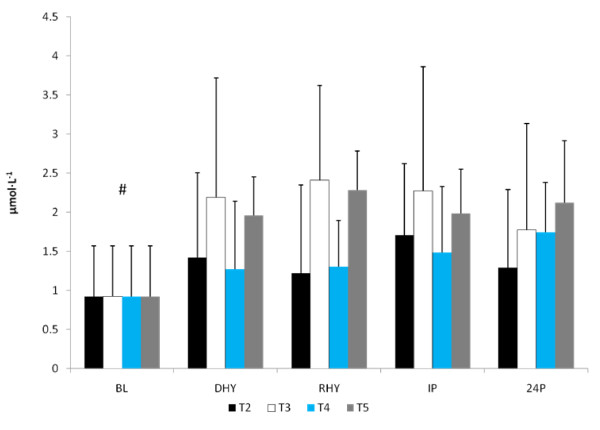
MDA Response. # = significant main effect for time versus DHY, RHY, IP, and 24P; There was a significant main effect for Trial between T3 and T5 versus T2 and T4.